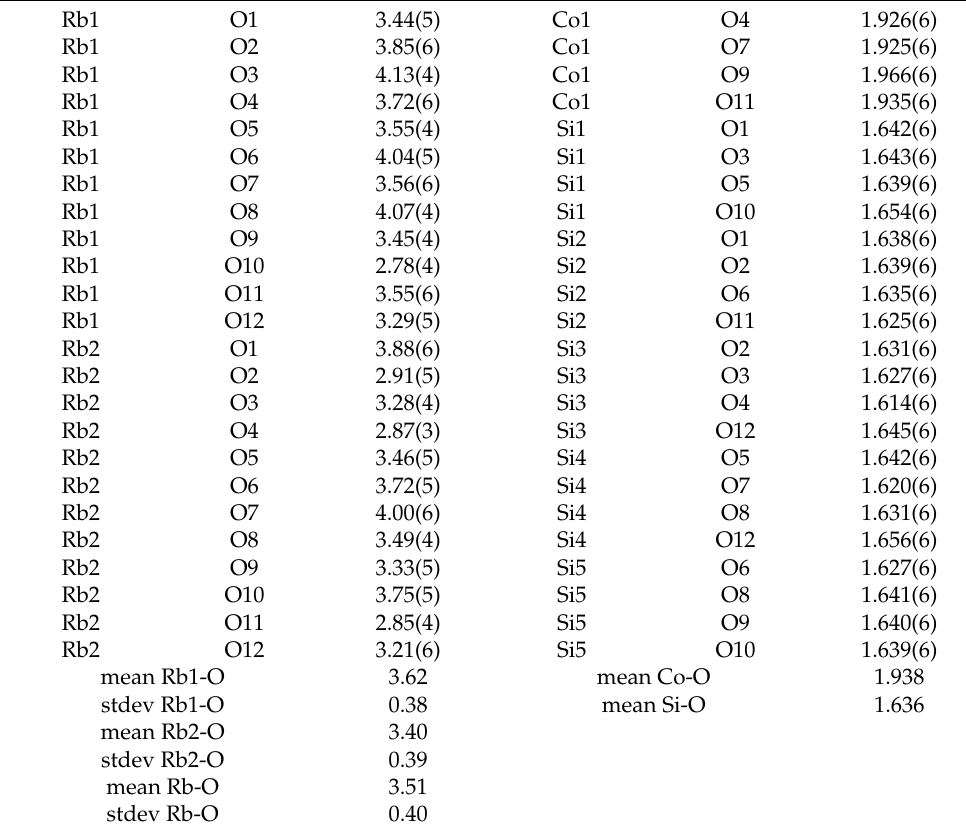
Table 2. Refined interatomic distances (Å) for ambient temperature Rb 2 CoSi 5 O l2 .